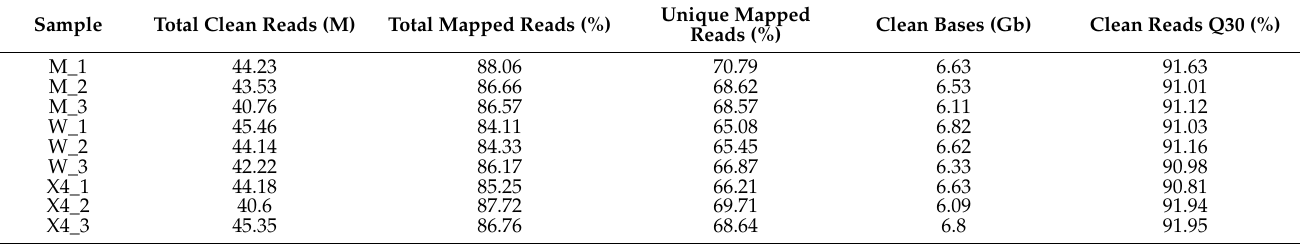
Table 1. Statistical results of RNA-Seq.